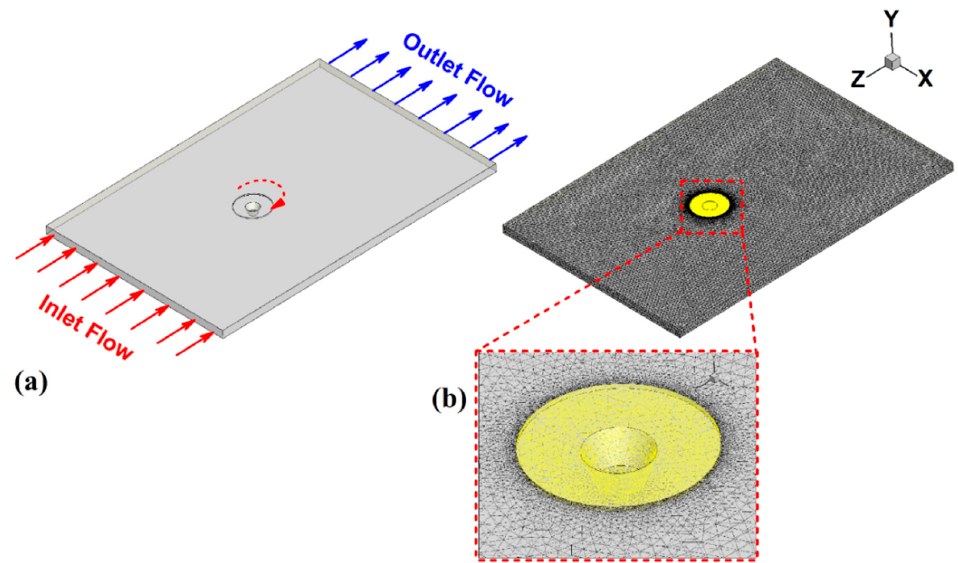
Figure 1. ( a ) Schematic view of the FSW domain. ( b ) Meshed domain.